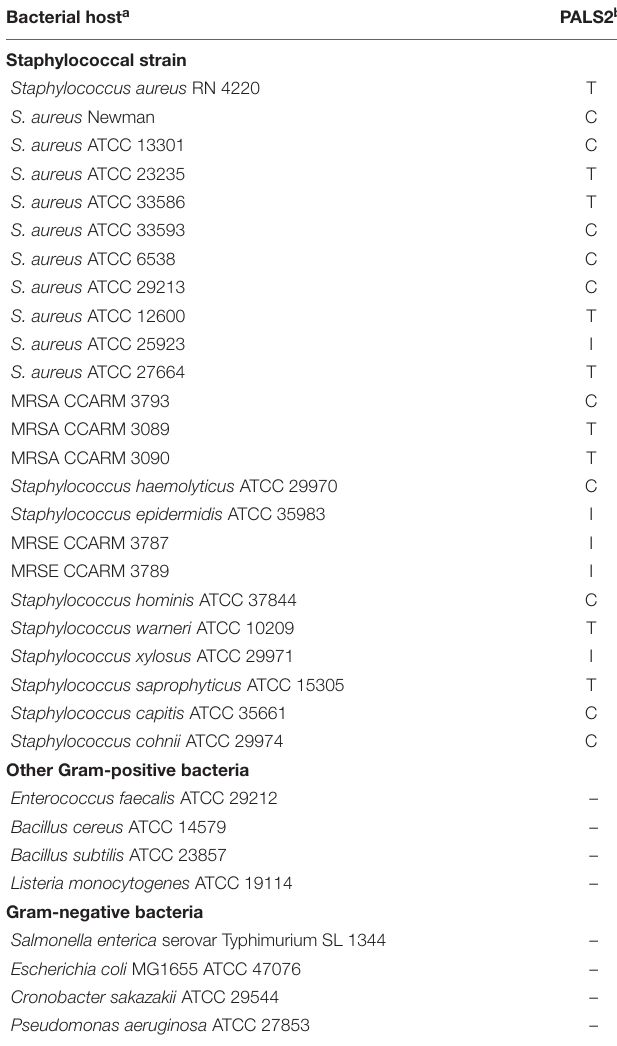
TABLE 1 | Antimicrobial spectrum of phage PALS2 against different bacterial species.